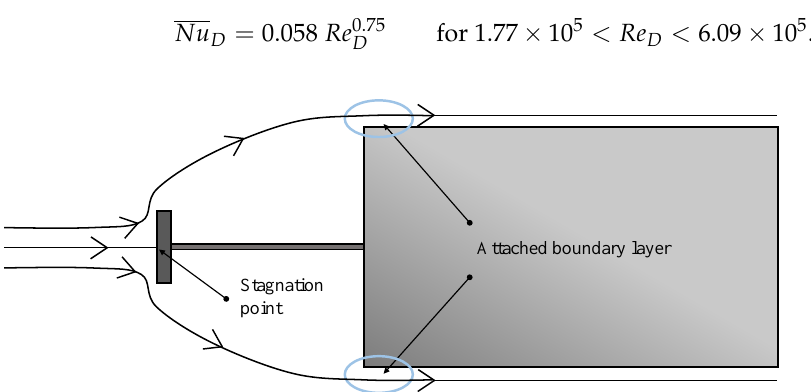
Figure 5. Stagnation point position and flow streamlines for the disc and cylinder under an axial flow